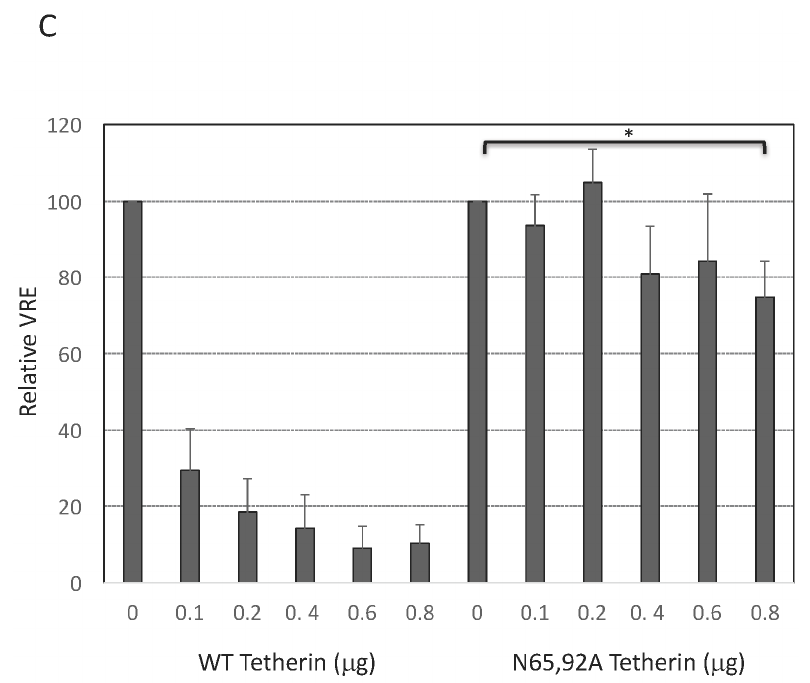
Figure 2. Lack of antiviral activity of N65,92A tetherin is associated with impaired cell-surface expression. ( A ) 293T cells were transfected with the delVpu HIV-1 molecular clone, and increasing amounts (0.1 to 0.8 μ g) of HA-tagged WT or N65,92A tetherin expression vector, and 0.1 μ g of GFP expression vector. One day post transfection cells were washed, harvested, untreated (control), or